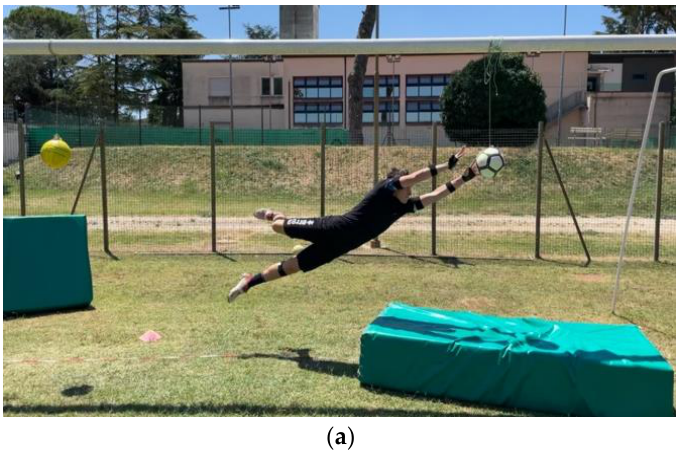
Figure 1. Set-up adopted for the data collection. The football goal was in a regular football pitch with natural grass. The mattresses were used to limit the risk of injuries to the goalkeepers and of damage to the wearable units. The balls for high dives were tied to the crossbar through a rope. The goalkeepers’ starting position was backwards the goal line (as showed by the shape) to allow a more natural diving moment (especially for high dives). The red lines indicate the direction of the high dives, and the blue lines indicate the low dives.